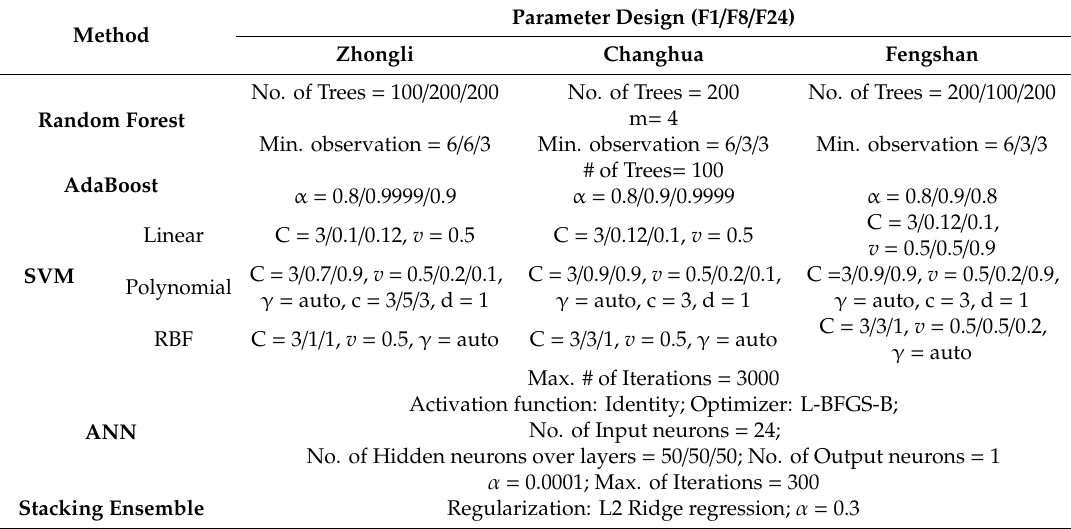
Table 3. Parameter Design of ML Methods.